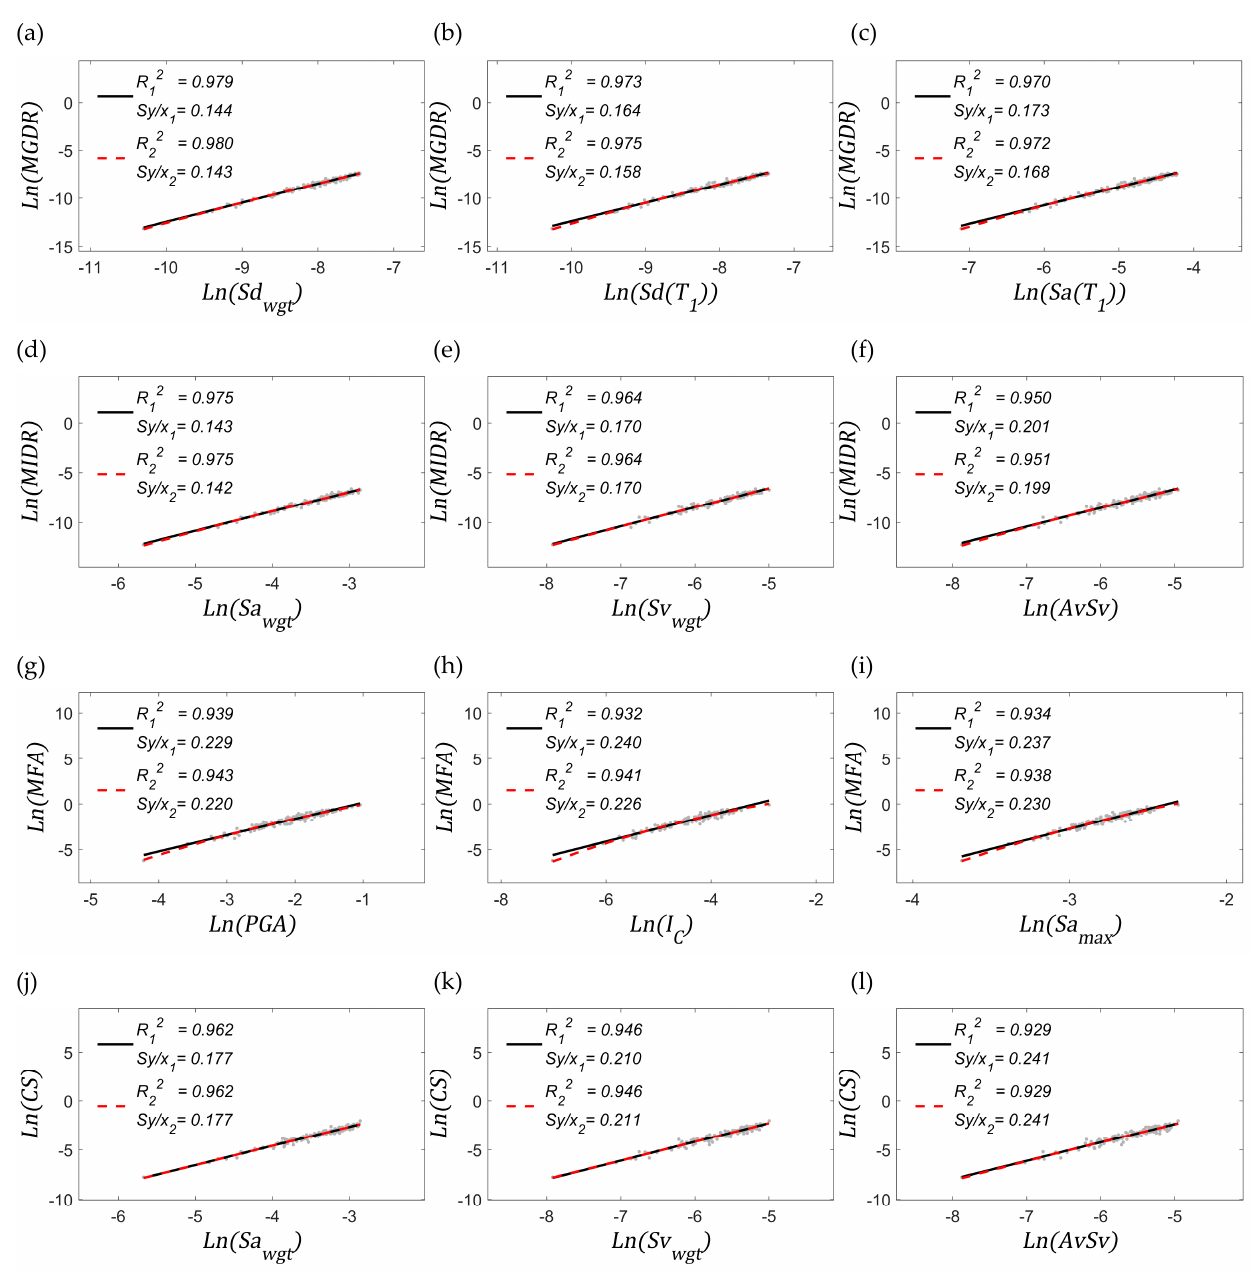
Figure 6. ( a – l ) Statistical properties calculated with elastic results; in these figures 𝑁 (cid:3010)(cid:3014) is equal to